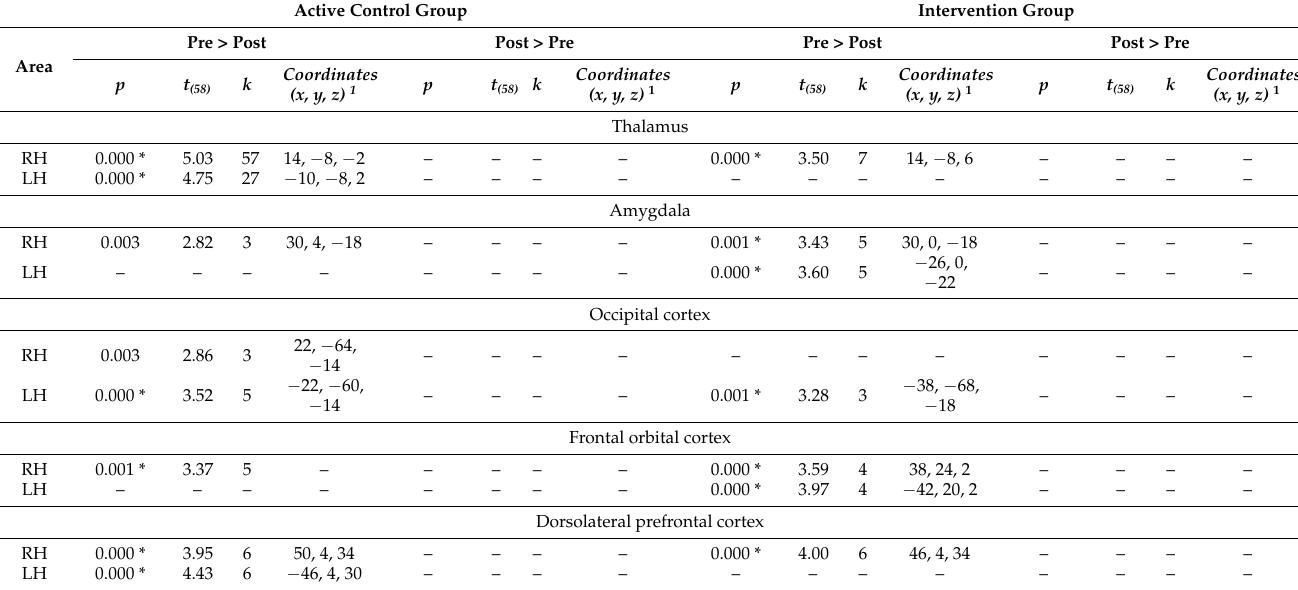
Figure 3. Main image effect ( p < 0.001). The figure shows the differential brain activation of all participants (intervention group and active control group) caused specifically by exposure to images of the phobic stimulus (regardless of the exposure condition: virtual or real, depending on the group). The degree of activation ranges from red (not very intense) to white (very intense). Table 3. Differential functional brain activation: before (pre) and after (post) treatment.